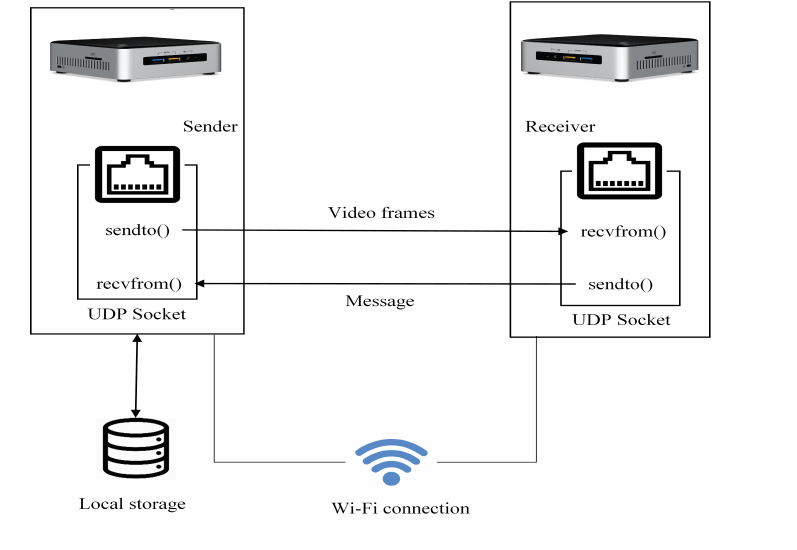
Figure 5. Testbed communication